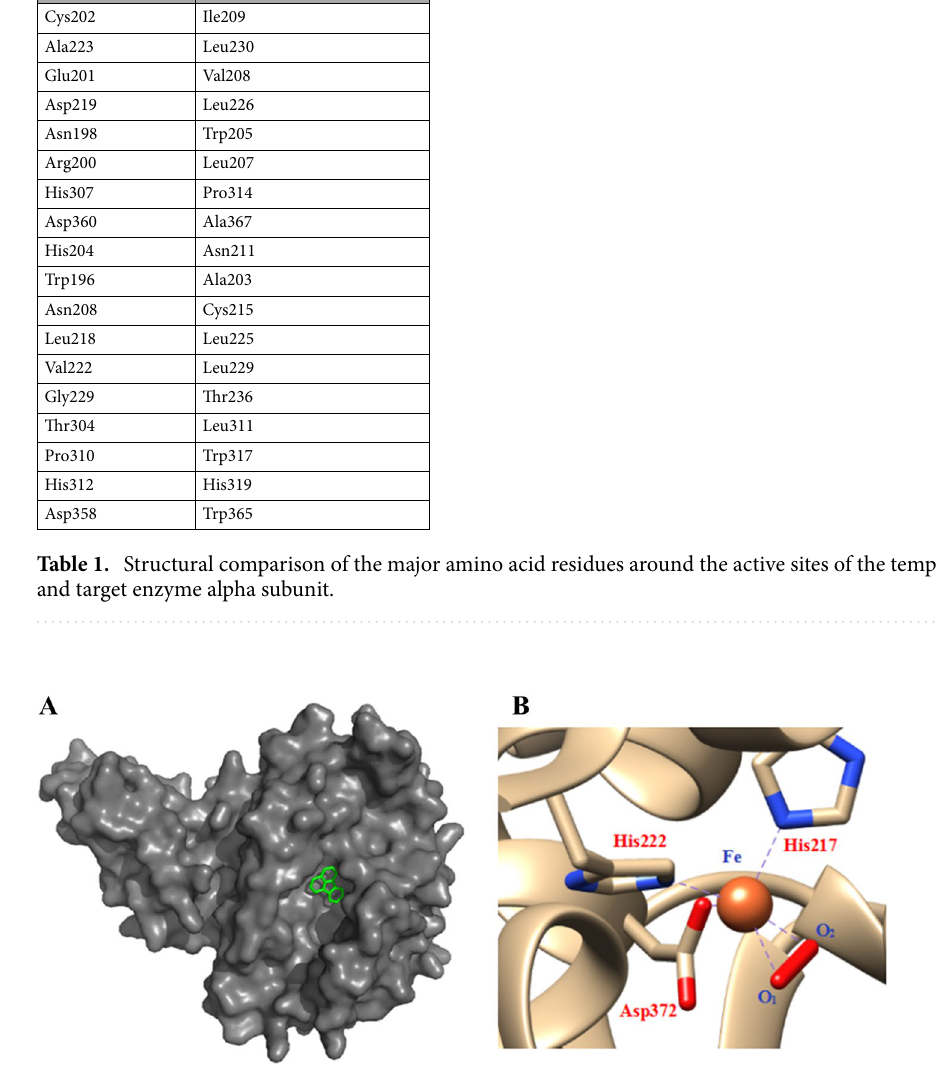
Figure 3. The combination state of fluoranthene in the active site of RHD ( A : fluoranthene structure was shown in stick mode and colored green ) and the composition of the active site in RHD alpha subunit ( B : a triangle structure of the mononuclear iron atom and the two oxygen atoms combined with a catalytic ternary of His 217 -His 222 -Asp 372